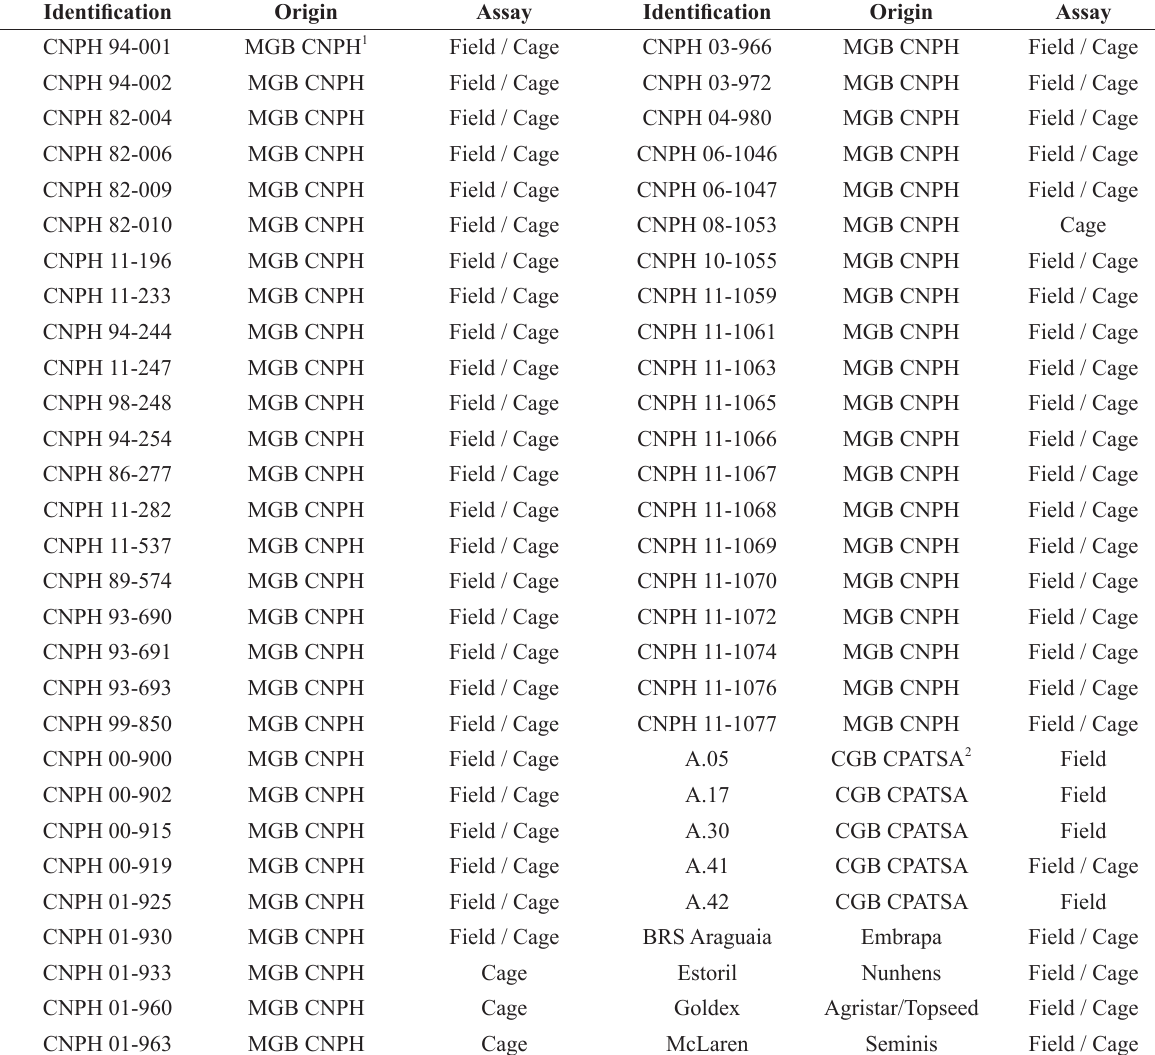
Identification and origin of the melon germplasm evaluated for resistance to vegetable leafminer in the field and, or in a cage, Fortaleza, CE, Brazil,